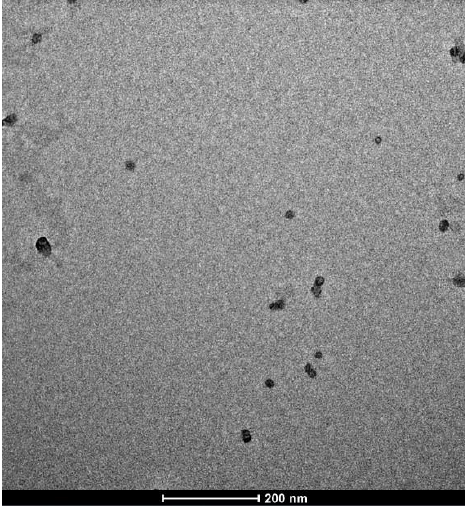
Figure 1. Transmission electron microscopy (TEM) image of solid lipid nanoparticles (SLN) containing oleth-20 as surfactant and idebenone (IDE) 1.1% w/w .